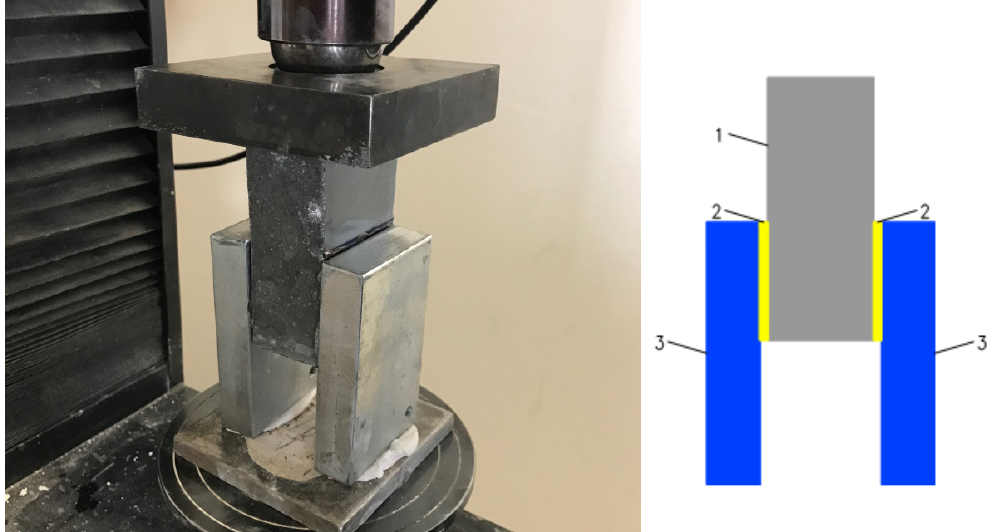
Figure 2. Results of the tensile